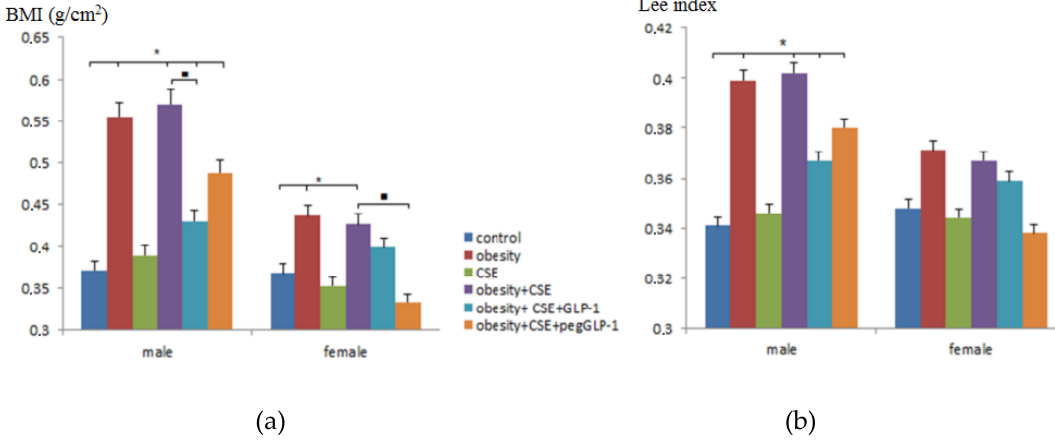
Figure 1. The e ff ect of glucagon-like peptide-1 (GLP-1) and pegylated GLP-1 (pegGLP-1) on body mass index (BMI) and Lee index of male and female C57BL / 6 mice on p189: ( a ) The BMI (g / cm 2 ); ( b ) The Lee index. Groups: control—a control group from intact mice, obesity—mice with metabolic disorders (obesity and hyperglycemia), CSE—mice with lungs emphysema, obesity + CSE—mice with metabolic disorders (obesity and hyperglycemia) and lungs emphysema, obesity + CSE + GLP-1—mice with metabolic disorders (obesity and hyperglycemia) and lungs emphysema treated with GLP-1, obesity + CSE + pegGLP-1—mice with metabolic disorders (obesity and hyperglycemia) and